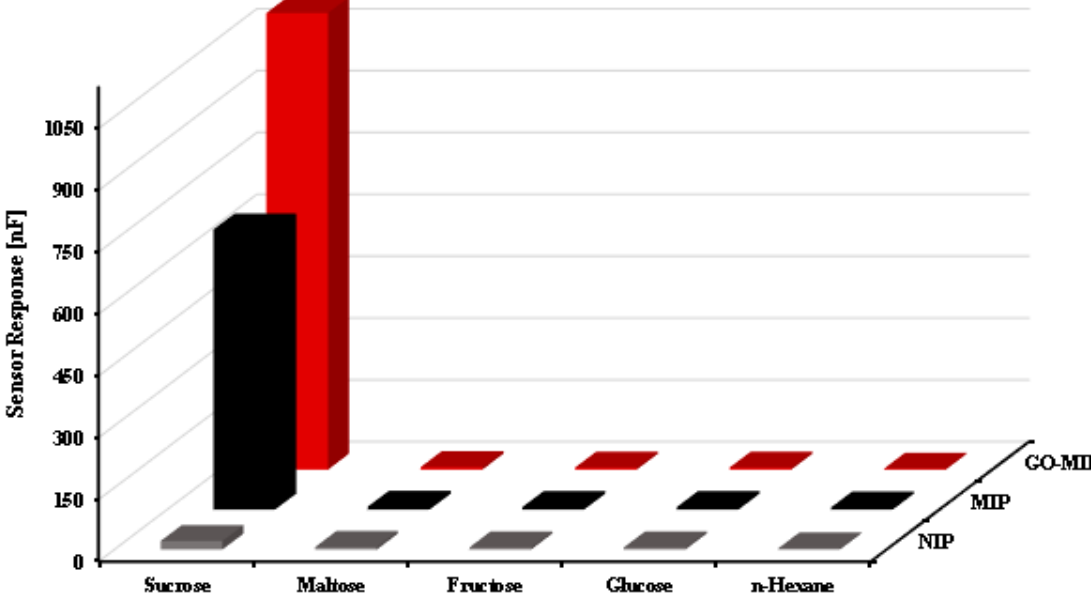
Figure 9. Selectivity behavior of MIP of sucrose and its composite toward maltose, glucose, fructose, and n-hexane at 50 ppm.